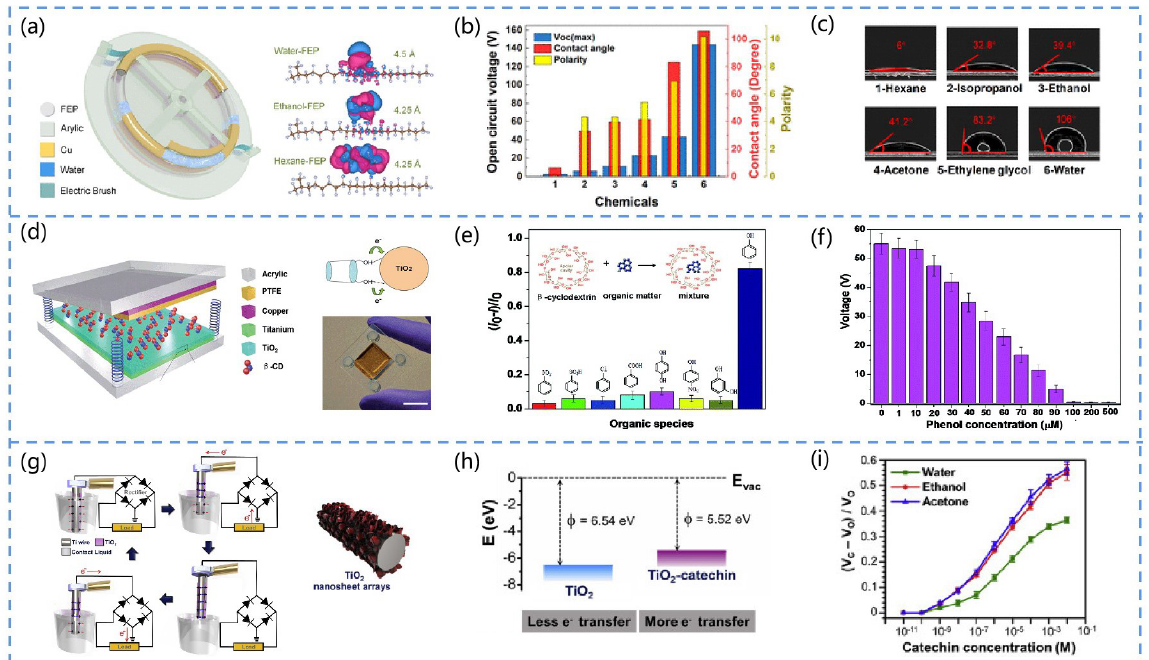
Figure 16. ( a ) The structure of a DC-TENG. ( b ) Effect of liquid on the output performance of the TENG (1, hexane; 2, isopropanol; 3, ethanol; 4, acetone; 5, ethylene glycol; 6, deionized water). ( c ) Liquid contact angle test. Reprinted from [115] with permission from ACS Publications. ( d ) Schematic diagram of a TENG modified with cyclodextrin. ( e ) Schematic representation of the selectivity of the device for monitoring phenol. ( f ) Schematic diagram of voltage signal for monitoring phenol concentration. Reprinted from [116] with permission from the Royal Society of Chemistry. ( g ) Diagram of solid – liquid TENS operation and TiO 2 nanosheet arrays. ( h ) Plot of catechin-induced change in work function. ( i ) Comparison of the output voltage ratio profiles and voltage enhancement coefficients for different catechin concentrations in different contact liquids, such as water, ethanol, and acetone, respectively. Reprinted from [117] with permission from Elsevier.